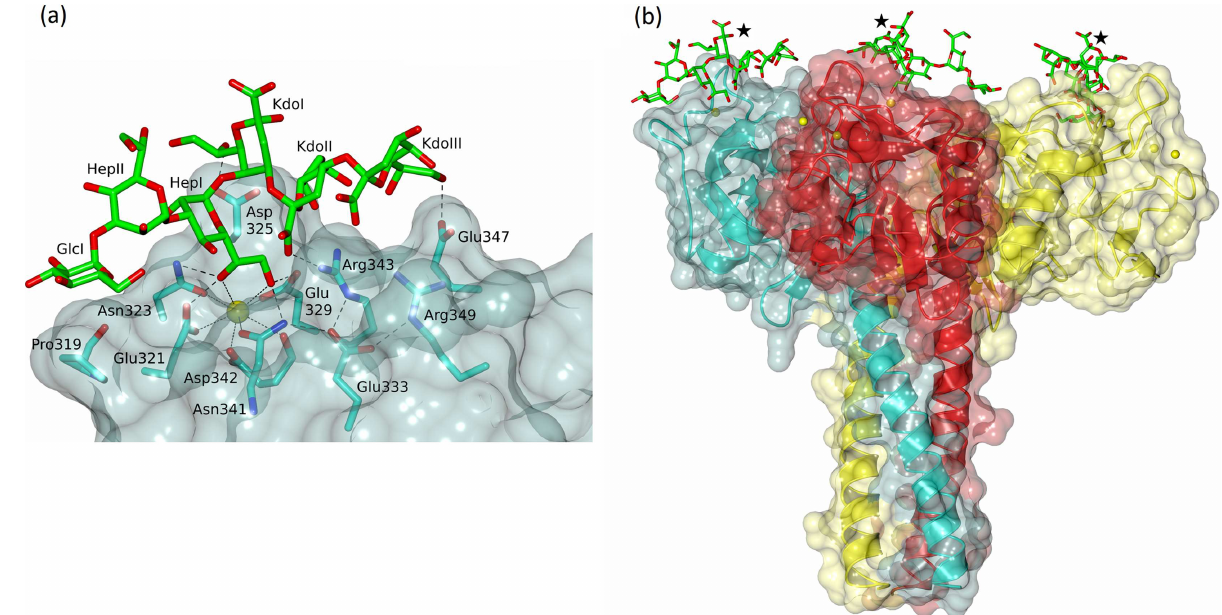
Fig 8. Model of complete S . enterica R5 oligosaccharide bound to rfhSP-D with the inner core HepI in the Ca1 binding site. KdoI (intact) is positioned to interact with Asp325, with KdoII and KdoIII interacting with Arg343 and Glu347 respectively. (a) subunit C, R5-bound structure (b) the rfhSP-D trimer with R5 similarly placed in each subunit and the link to lipid A from KdoI O2’ indicated by $ .